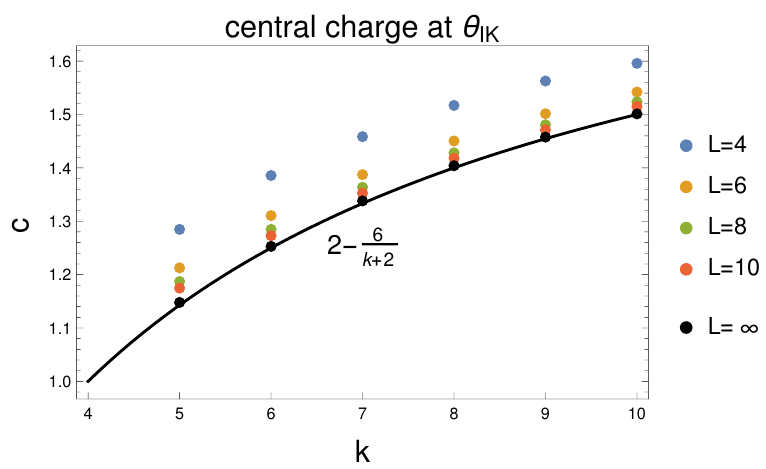
Figure 6: Central charge at the point θ , obtained from exact diagonalization of the Hamil- IK tonian (28) for finite system sizes, and using the expressions (29) of the thermodynamic limit free energy and Fermi velocity. The black dots are an extrapolation to L → ∞ using a quadratic fit in L − 1 . In comparison, we plotted in black the parafermionic central charge (23).